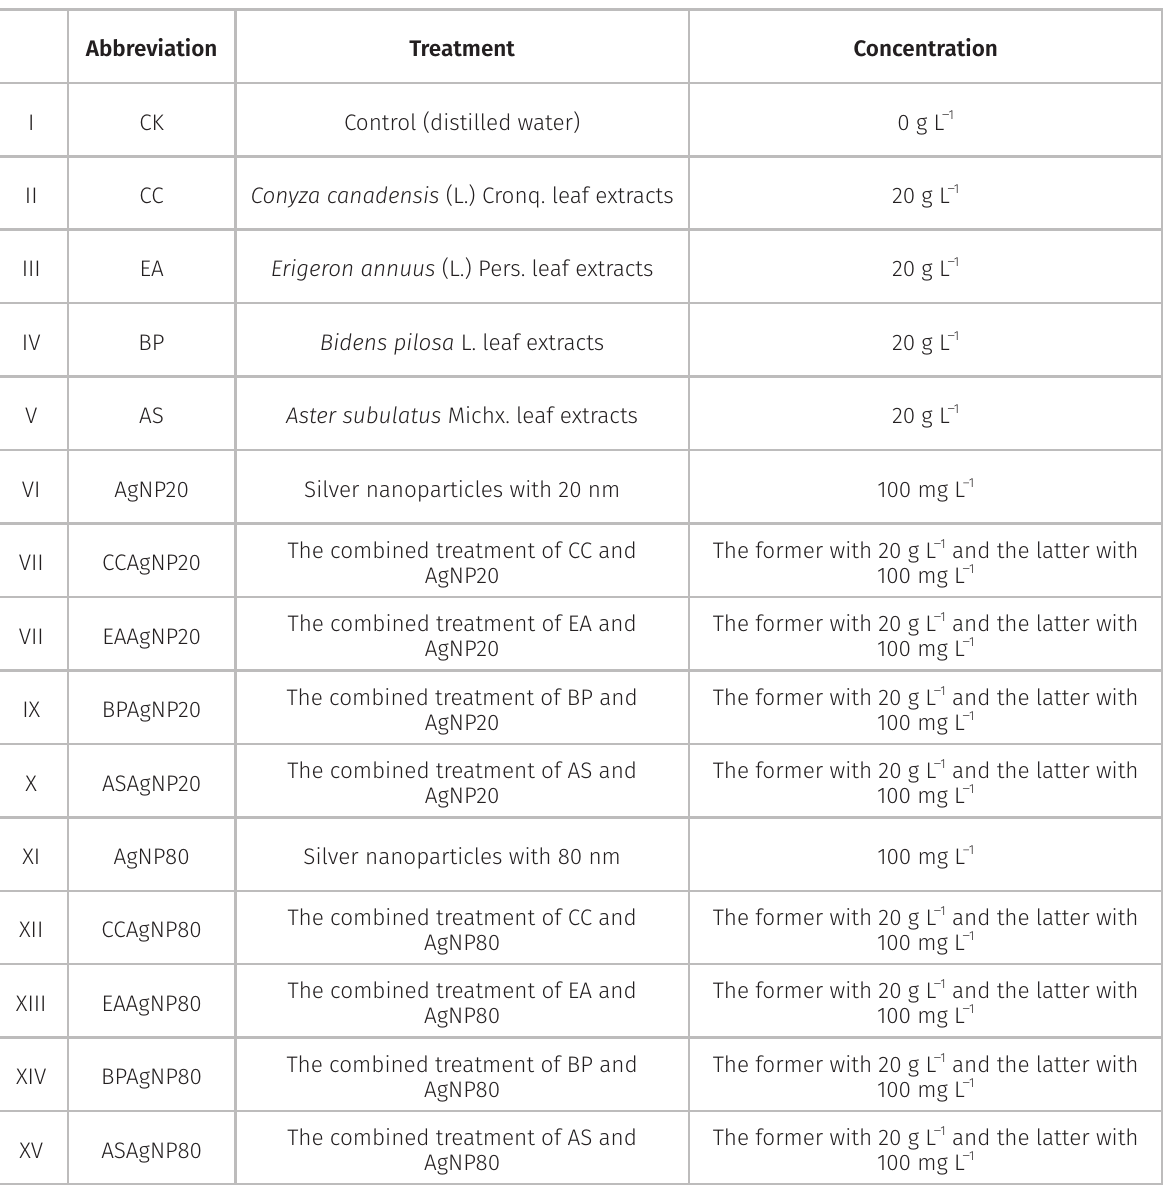
Table I. Summary of experimental